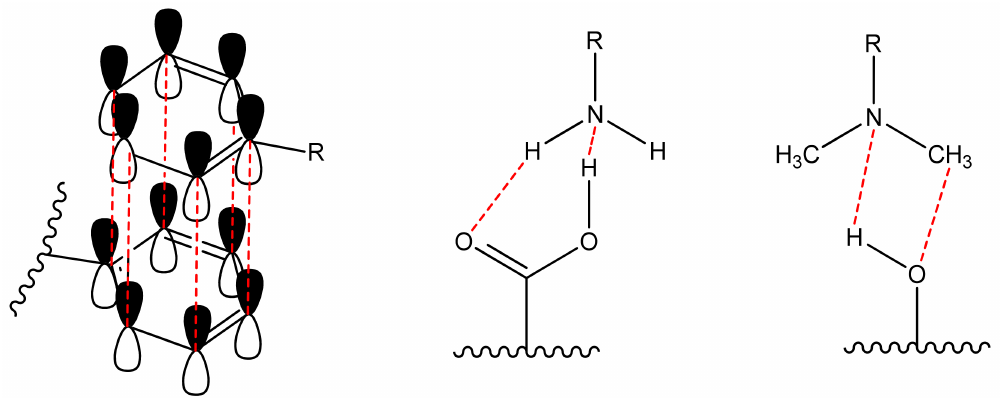
Figure 2. Scheme of non-covalent bonding between dye and matrix ( π - π stacking and hydrogen